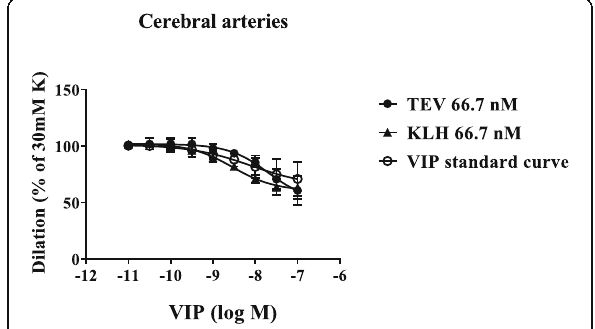
Fig. 4 Human intracranial arteries were pre-contracted with 30 mM potassium buffer. The curves show dilatation in response to increasing concentrations of VIP 10 − 11 to 10 − 7 M in the presence of 66.7 nM of the monoclonal antibody against CGRP (fremanezumab) or an isotype control (KLH). The data show mean±SEM, n =2 – 4 for each concentration. K:potassium; TEV:Teva; VIP:vasoactive intestinal